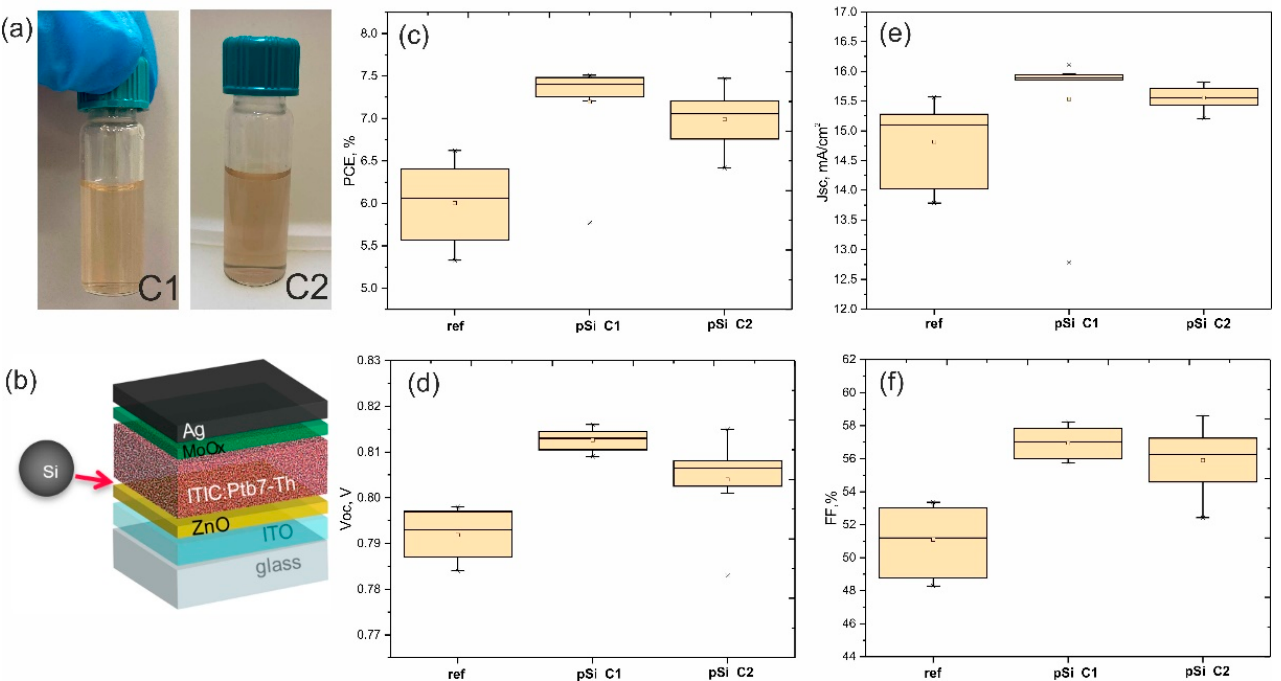
Figure 3. ( a ) Photographs of colloidal solutions of Si NPs in isopropanol with two concentrations: lower (C1) and higher (C2). ( b ) Schematic illustration of the architecture of the studied organic solar cell; an arrow indicates the position of the Si NPs layer. ( c – f ) PCE, Jcs, Voc, and FF statistical data for reference solar cells, and for similar solar cells with two different concentrations of Si NPs-C1 (3 × 10 − 4 mol L − 1 ) and C2 (6 × 10 − 4 mol L − 1 ).